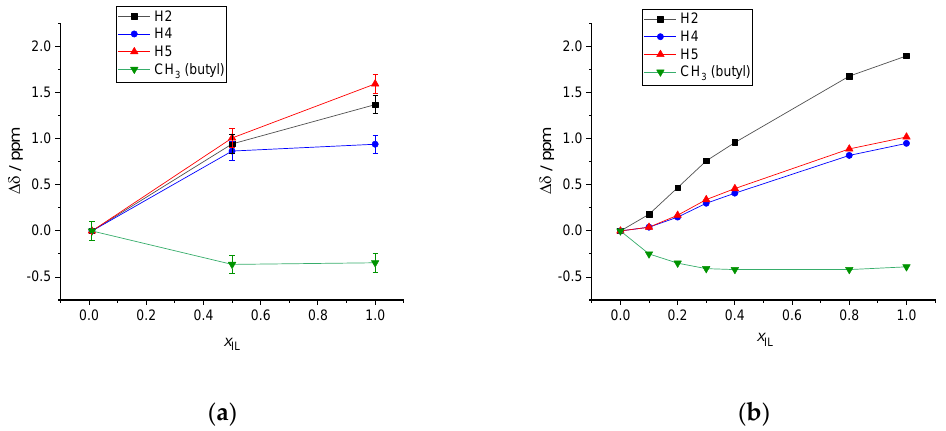
Figure 7. Relative chemical shift variation as a function of the composition of the [C 4 C 1 im]Cl / water mixture. ( a ) Average calculated values. ( b ) Experimental data from Ref. [25]. Connecting lines are merely a guide to the eyes.